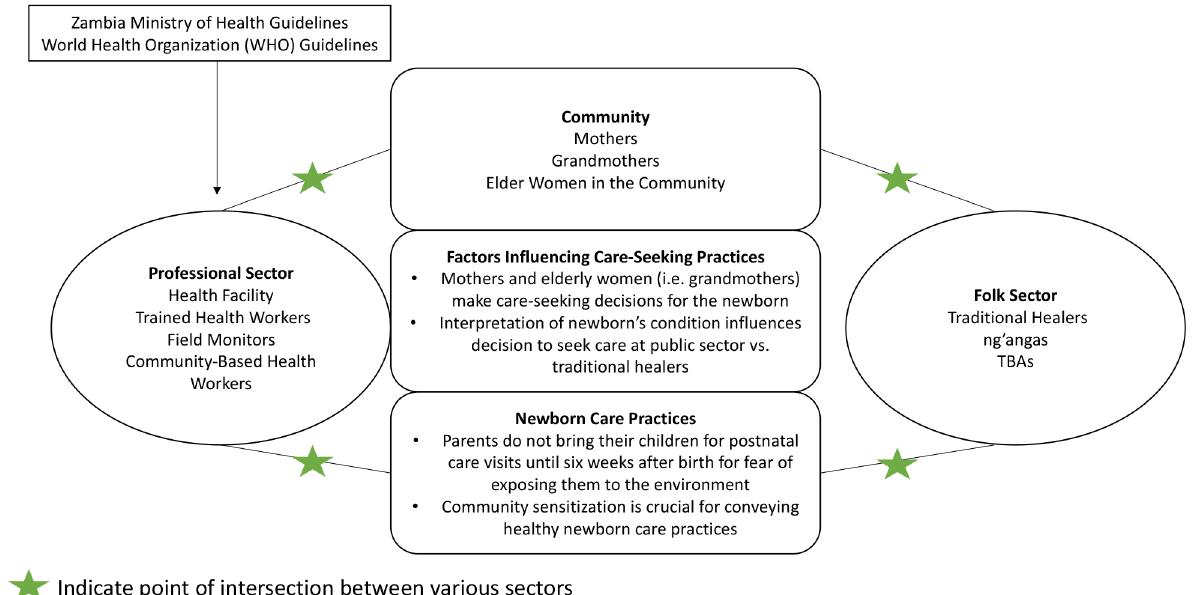
Fig 1. Adaptation of Kleinman’s local health system model as a behavioral model in Southern Province, Zambia.